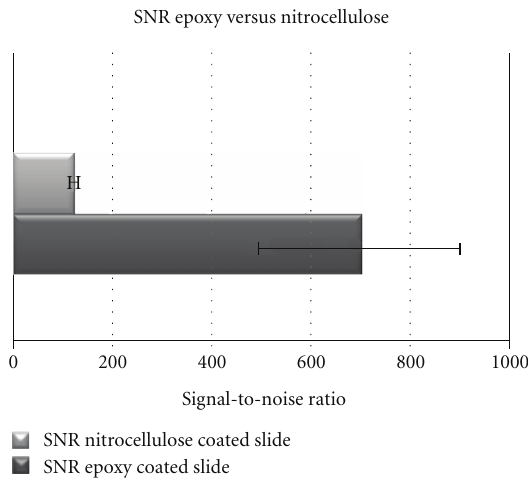
Figure 4: Comparison of the signal-to-noise ratio of the spots from Figure